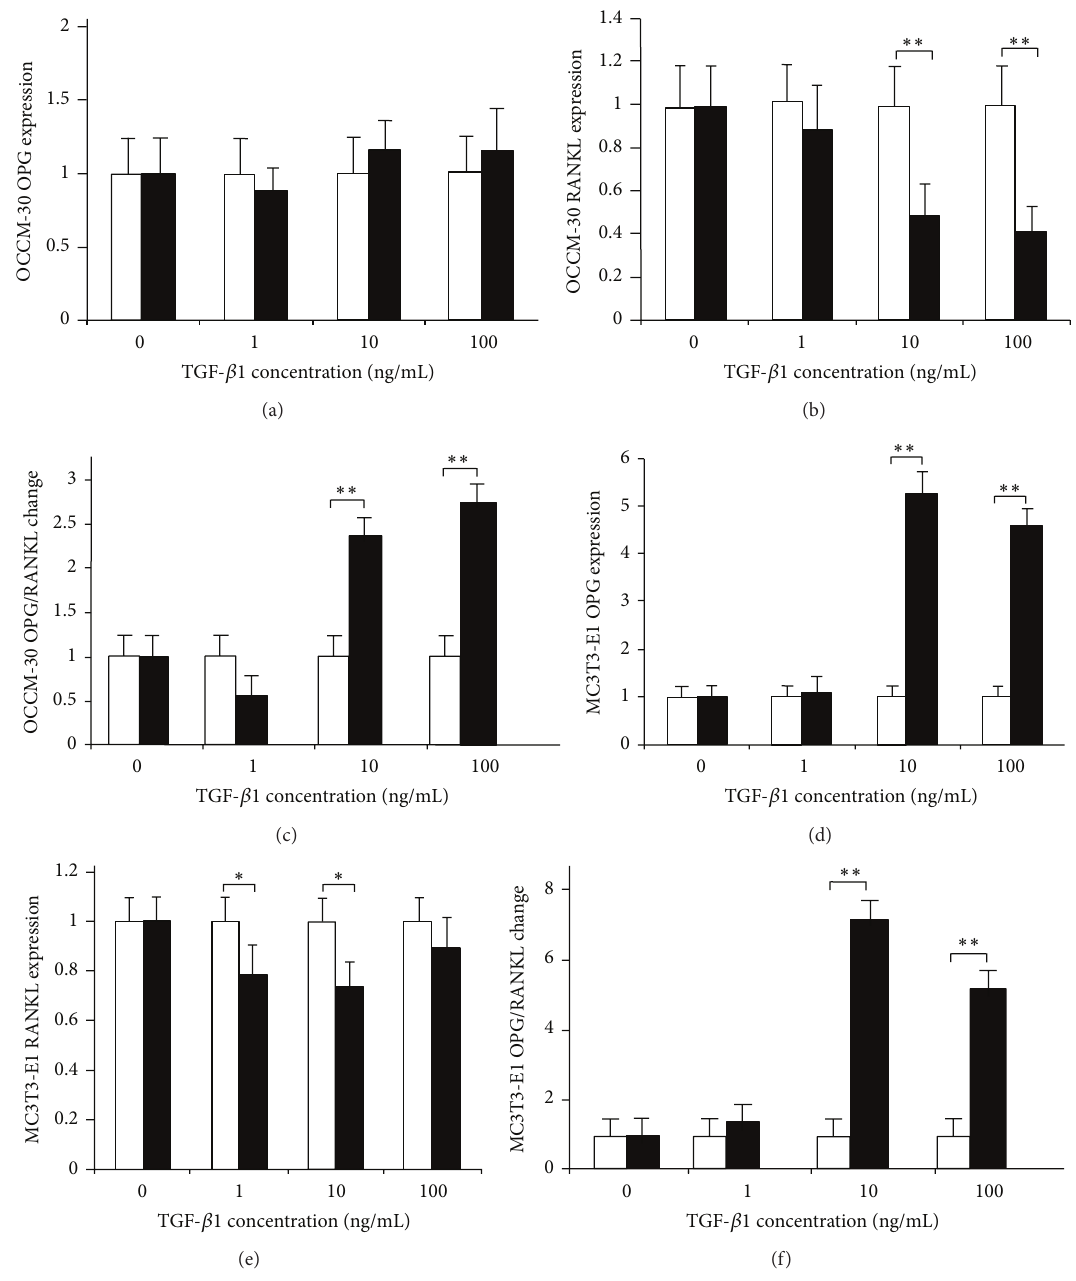
Figure 7: Effects of TGF- 𝛽 1 on cementoblasts and osteoblasts under 24 h mechanical compressive